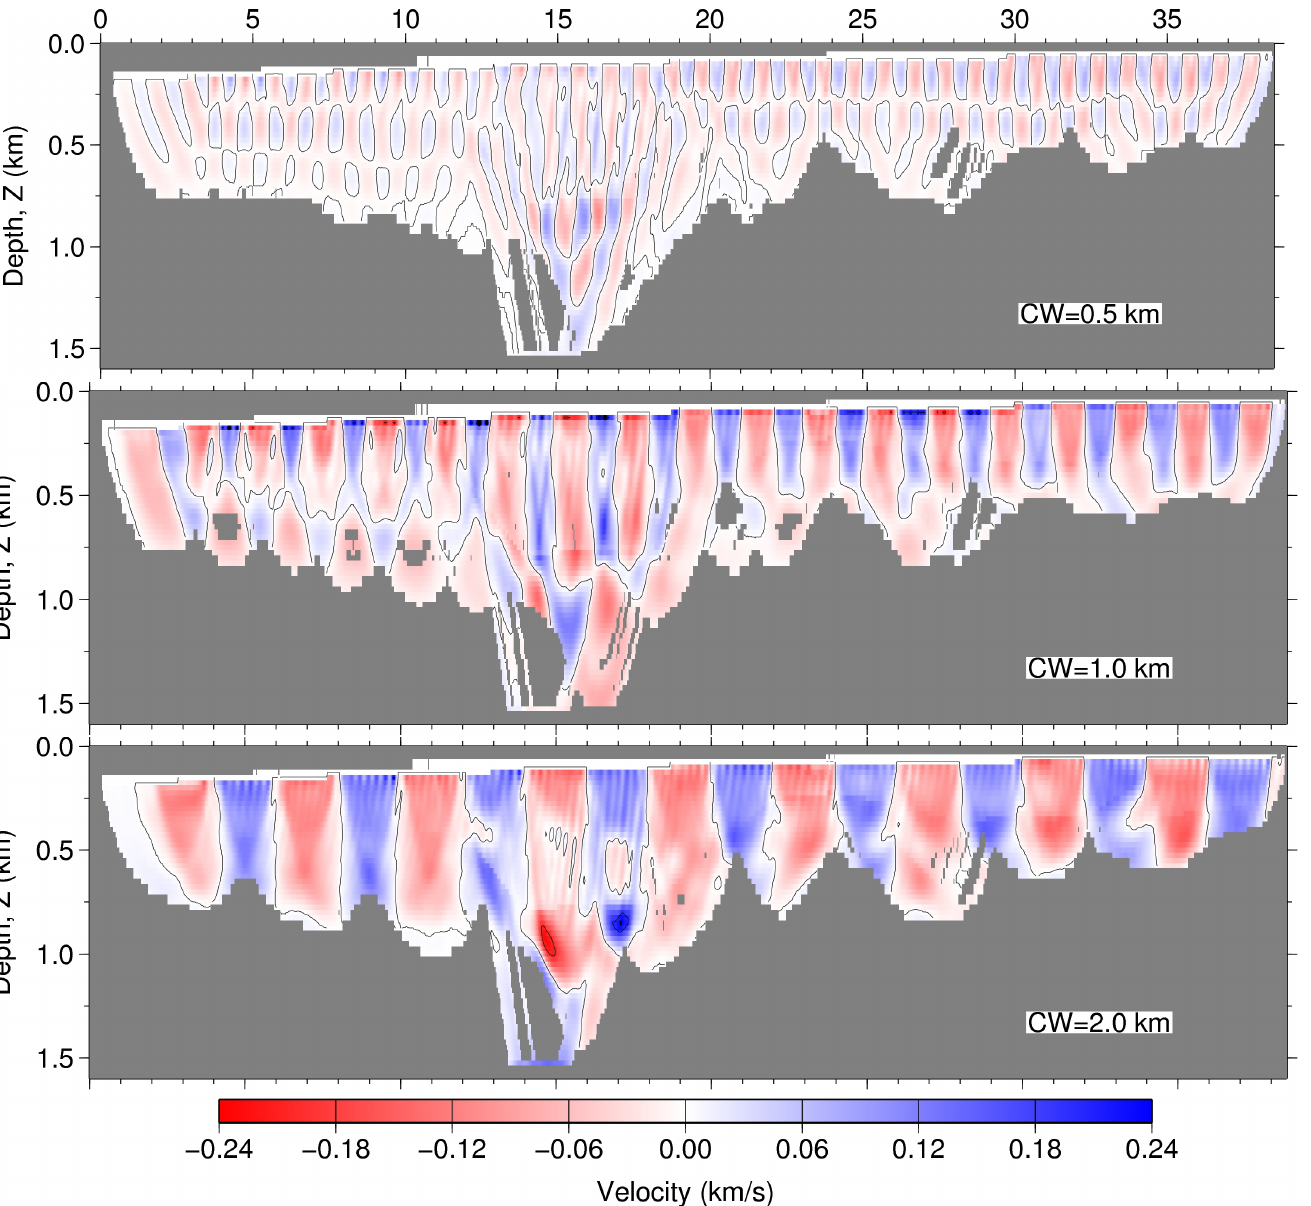
Figure 6. Corrugation models for vertical velocity perturbation of ± 500 m/s with corrugation widths (CW) of 0.5 km, 1.0 km, and 2.0